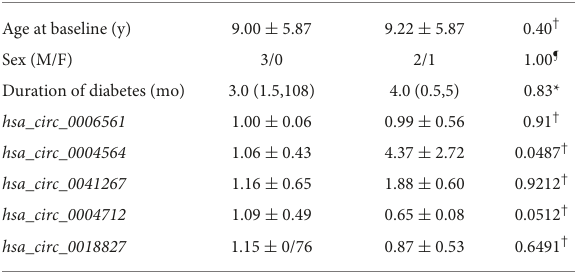
TABLE 2 Correlation between candidate circRNAs and celiac serology in the children with